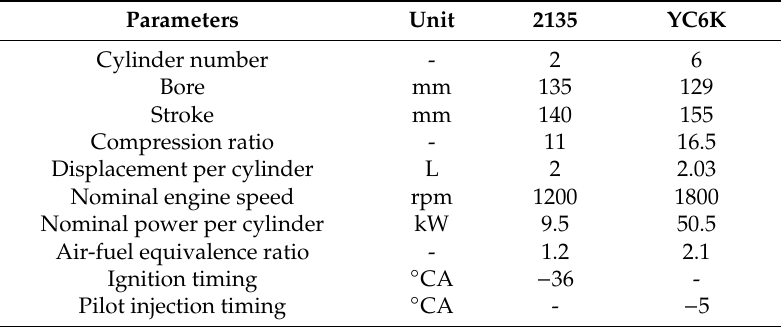
Table 1. Main characteristics of the investigated engines.